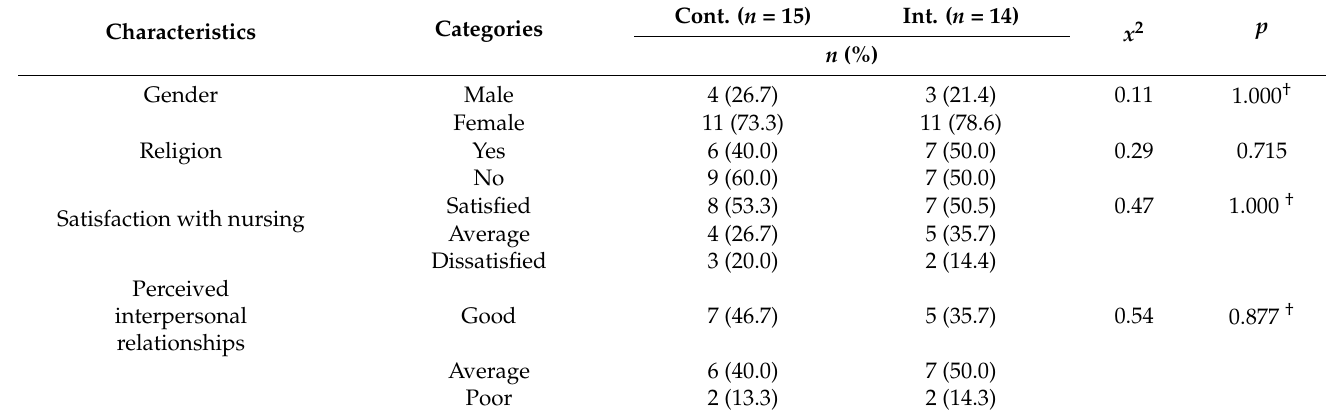
Table 2. Homogeneity test results for general characteristics between control and intervention groups.